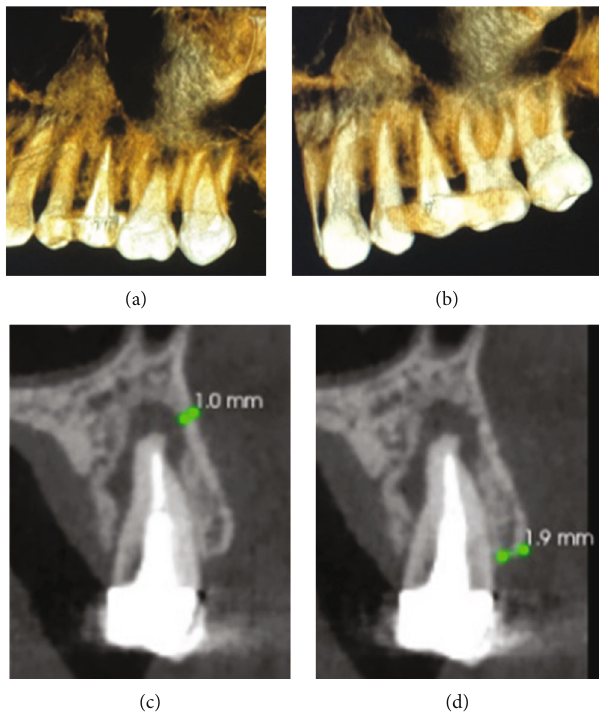
Figure 1: Palatal (a) and facial (b) views of M – D radiographic sections and facial plate thicknesses (c and